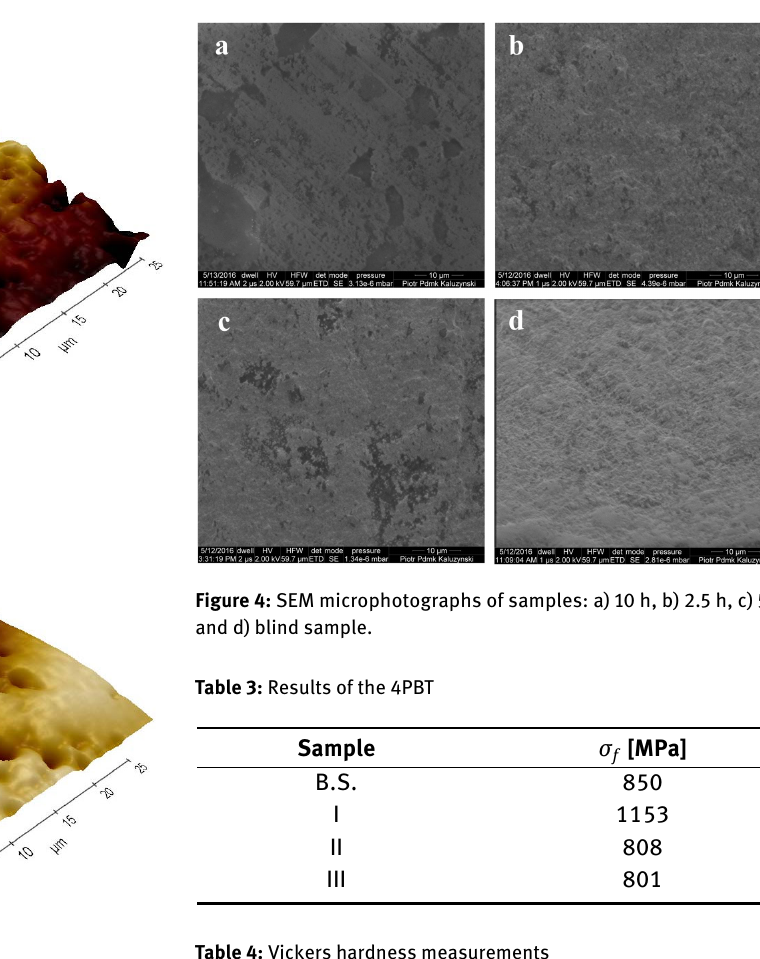
Table 4: Vickers hardness